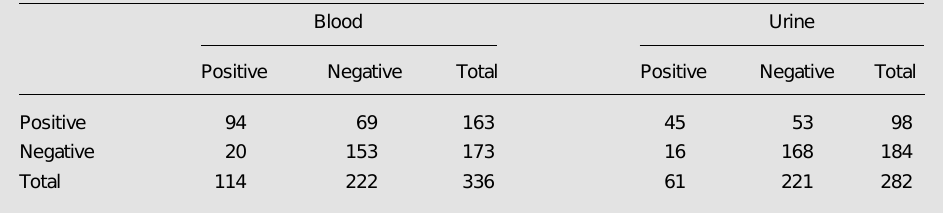
1 - Percentage of patients with CMV detected in blood and urine by nested-PCR with gB or gH primer sets. The number of patients studied is shown in pa-